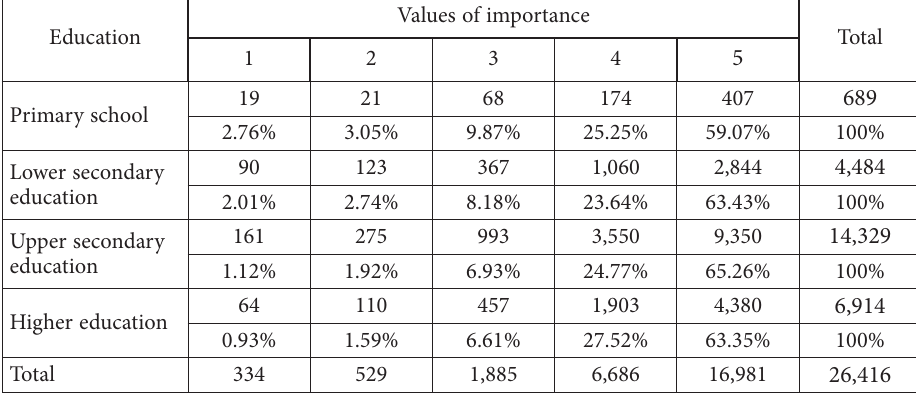
Table 4. Relative frequency for motivational factor base salary from the point of view of education